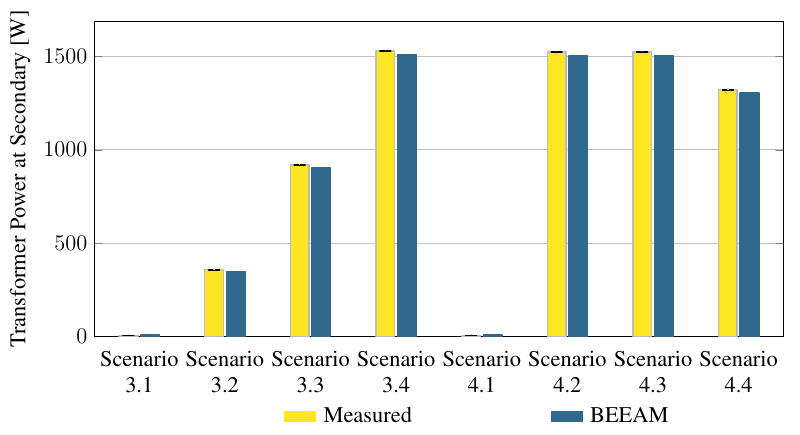
Figure A12. Predicted versus measured transformer power, secondary; Scenarios 3 and 4.